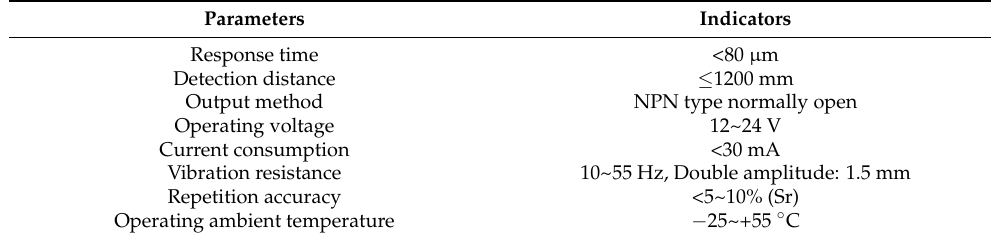
Table 1. Fiber optic sensor technical parameters.